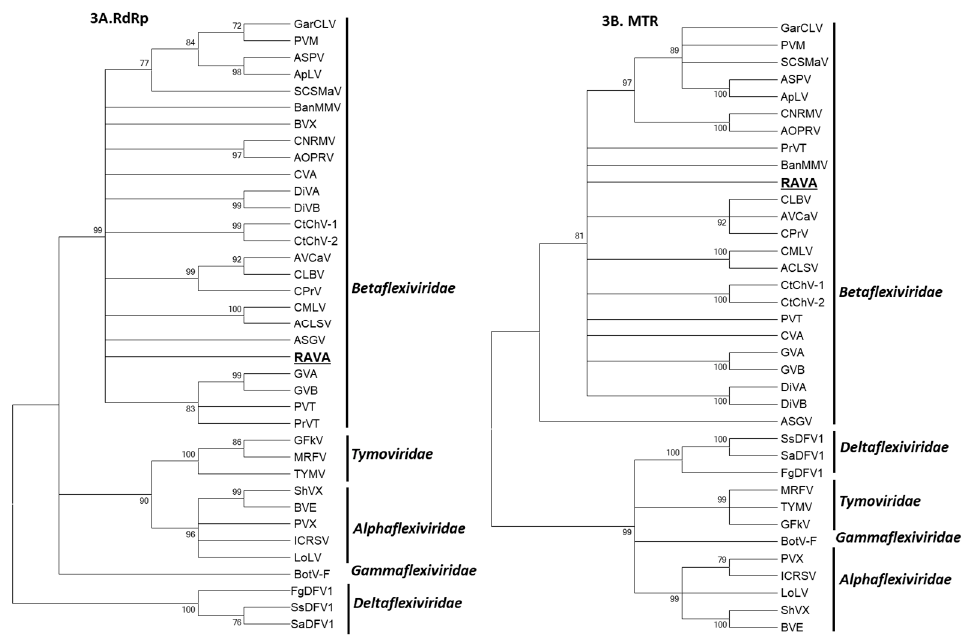
Figure 3. Phylogenetic relationship of Ribes americanum virus A (RAVA) with members of the order Tymovirales . Phylogenetic analysis was performed using the conserved domains of RNA-dependent RNA polymerase (RdRp; 3 A ) and methyl transferase (MTR; 3 B ). The trees were generated by the maximum likelihood method using MEGA 7 and bootstrap values (indicated for each branch node) were estimated using 1000 bootstrap replicates. The branches with bootstrap values less than 70% are collapsed. The details of virus isolates used for the studies are provided in Table 1.